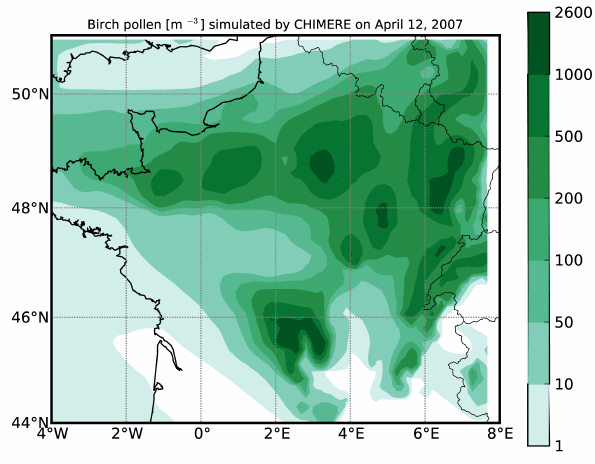
Fig. 19. Birch pollen concentrations (grains m − 3 ) simulated with CHIMERE for April 12, 2007.